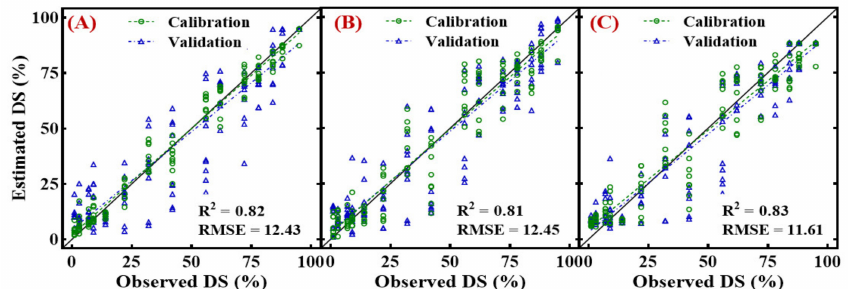
Figure 10. Illustration of the multivariate quantitative relationship between newly developed indices: wheat fusarium canopy indices (WFCI 1 and WFCI 2 ) and disease severity (DS) using the dataset of the first year (2020) for calibration (circles) and dataset of the second year (2021) for validation (triangles) with ( A ) random forest regression (RFR), ( B ) support vector machine regression (SVMR) and ( C ) Knn regression (KnnR) (the reader is referred to the article’s web version for interpreting— colored references in figure